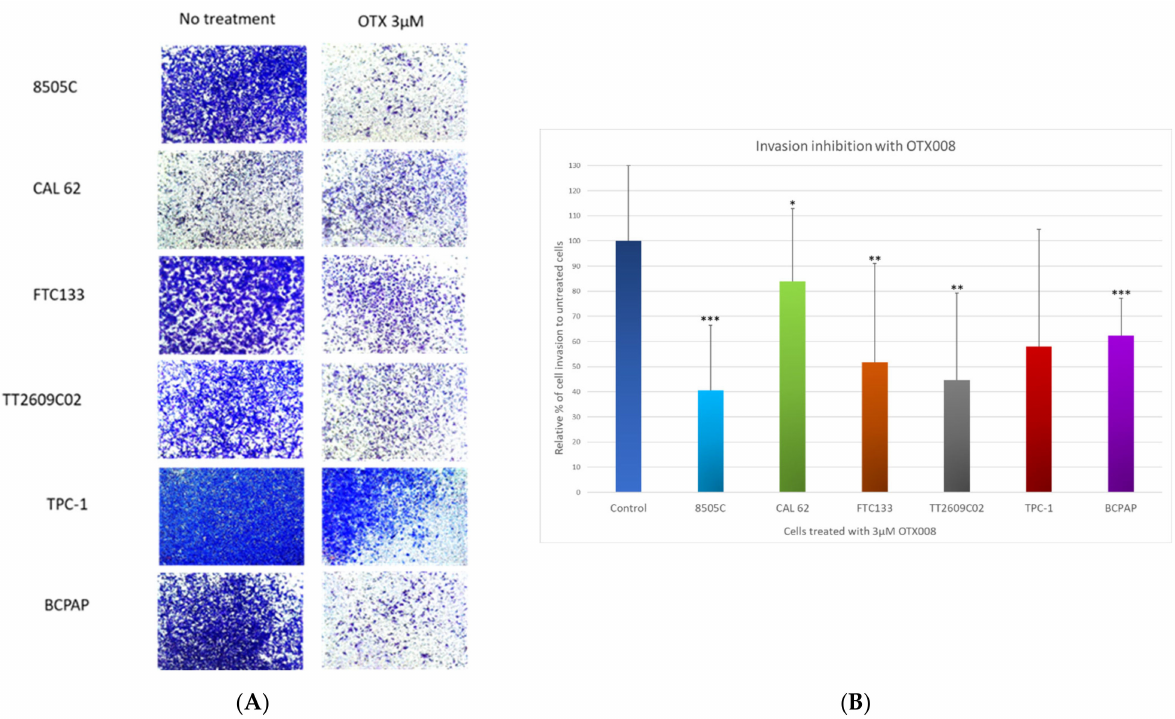
Figure 4. Evaluation of the anti-invasive properties of OTX008 in thyroid cancer cell lines. ( A ) Cells were plated in a Boyden chamber in media without FBS and with 3 µ M OTX008 for 48 h. ( B ) The percentage of invasiveness was determined by solubilization of invasive cells and quantification of the crystal violet staining at the optical density of 570 nm. Invasion values for untreated cells are normalized at 100% for each line and are represented once as Control. Statistical analyses refer to each respective control line. Student’s t-test was performed to assess significance regarding to respective control cells whose invasion capacity were normalized at 100% (* p < 0.05; ** p < 0.01; *** p <